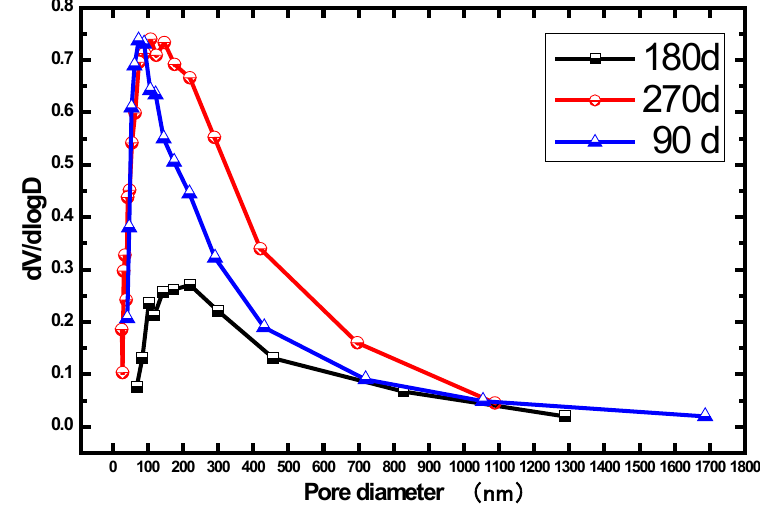
Figure 6. Pore size distribution of concrete CF15 sample immersed in distilled